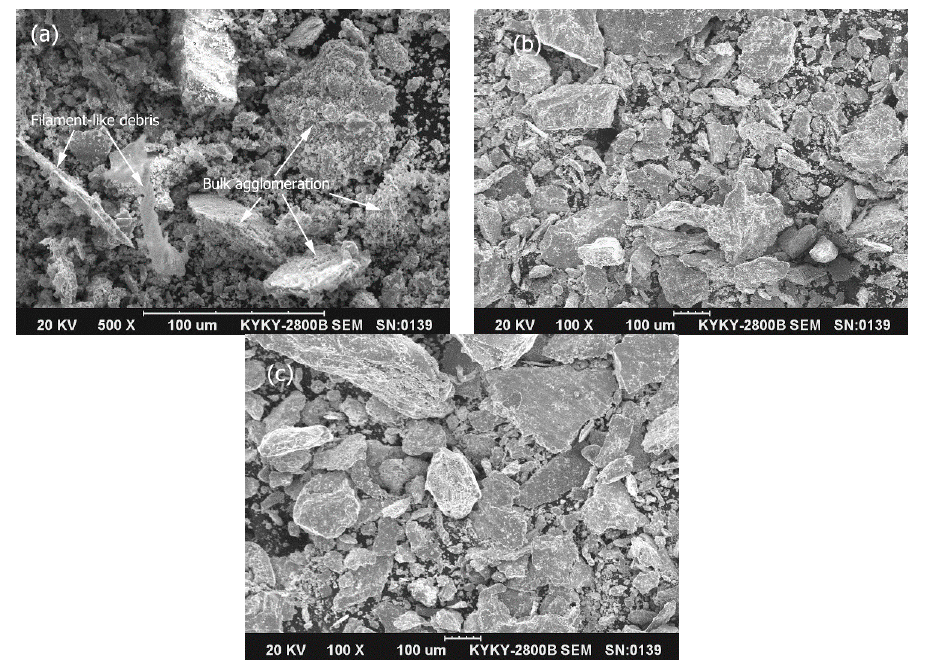
Figure 10. SEM micrographs of wear debris produced for the Mo–40Ni–13Si intermetallic alloy ( a ); the hardened 0.45%C steel ( b ); and austenitic 1Cr18Ni9Ti stainless steel ( c ).